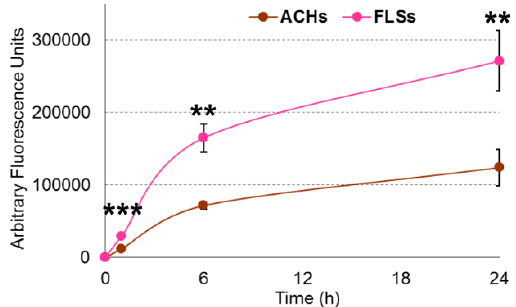
Figure 4. Di ff erential ASC-EV interaction with ACHs and FLSs over time in 2D. Fluorescence intensities in the FITC channel for ACHs and FLSs over time. N = 3, values are shown as mean ± SE Significance for p -value < 0.05. ** for p -value < 0.01 and *** for p -value < 0.001.